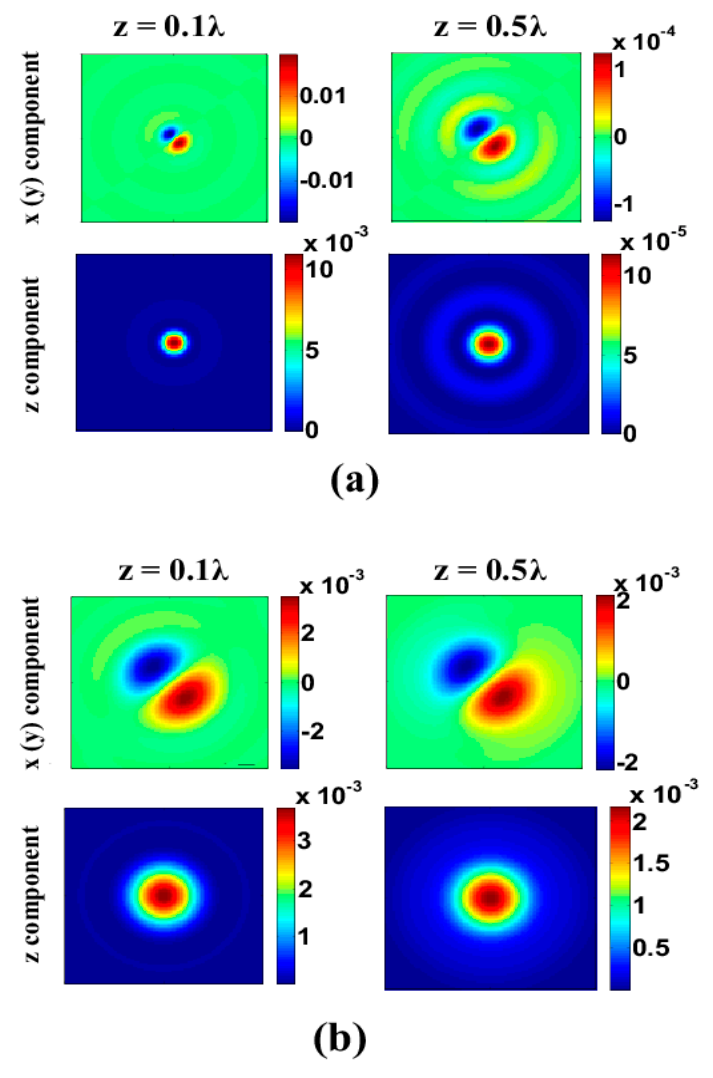
Figure 4. (Color online) The x , y , and z components of the spin angular momentum flux density (SAM-FD) of the evanescent wave and propagation wave with w = 0.1 λ , r 0 = 0.5 λ . Upper plots in ( a , b ) transverse ( x - or y -) component; lower plots in ( a , b ) z component. All the images have the same dimension of 2 × 2 λ 2 .